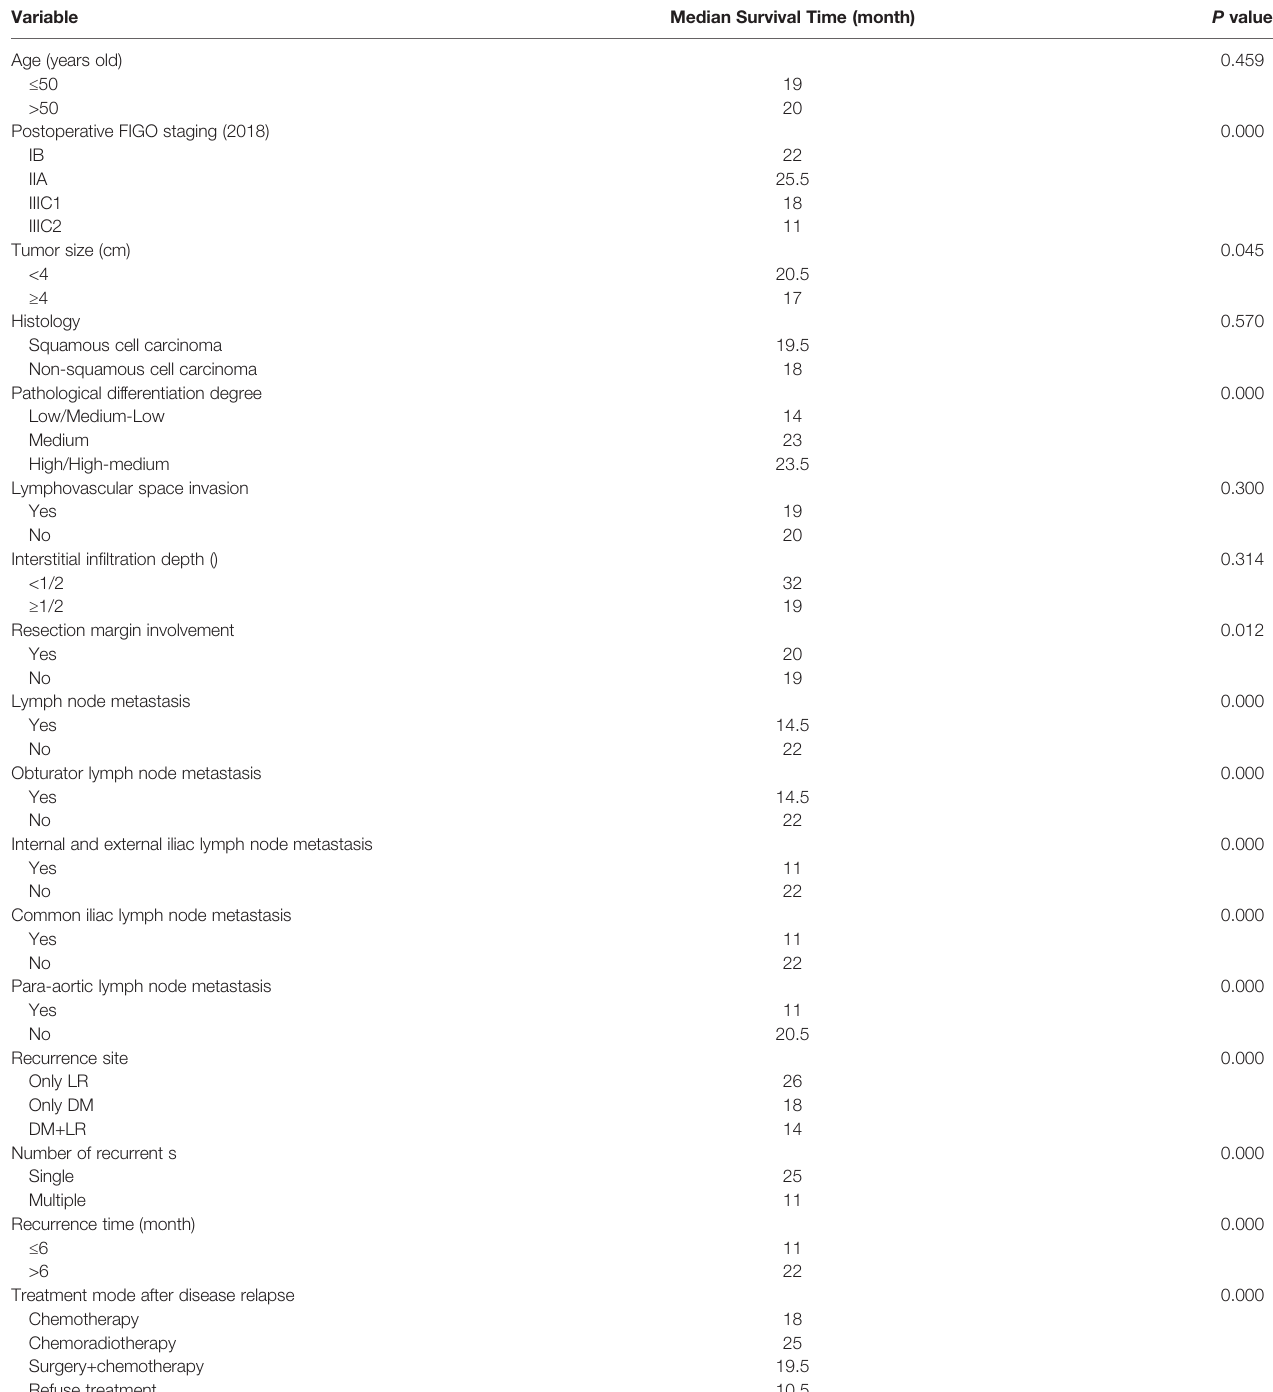
TABLE 4 | Univariate analysis for factors associated with survival outcomes in patients with recurrent cervical cancer.